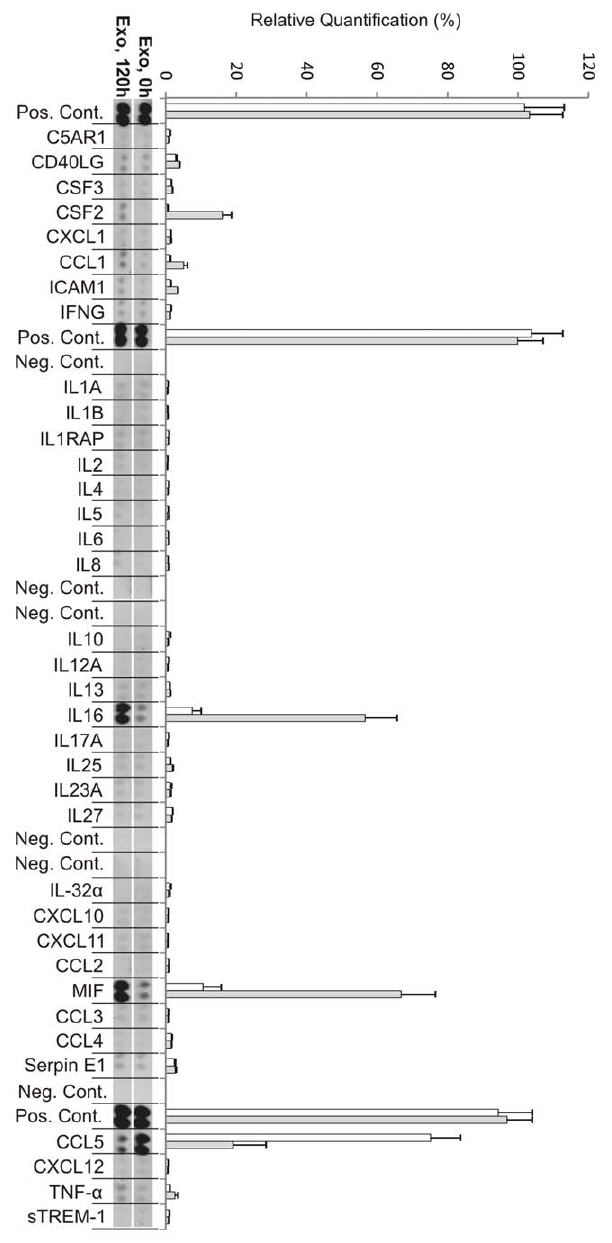
Figure 3. Cytokine production from autologous exosome stimulated CD3 + T cells at day zero (0 h) and day five (120 h). Relative quantification of spot intensities was performed using Quantity One software (Bio-Rad). Each bar represents an average of the intensity from two protein spots. White bars represent 0 h and grey bars represent 120 h (day 5). The exosomes appeared to contain significant amounts of CCL5 (RANTES) immediately after the addition of exosomes (at 0 h) since the supernatants showed relatively large amounts of RANTES. These levels were decreased at day five.